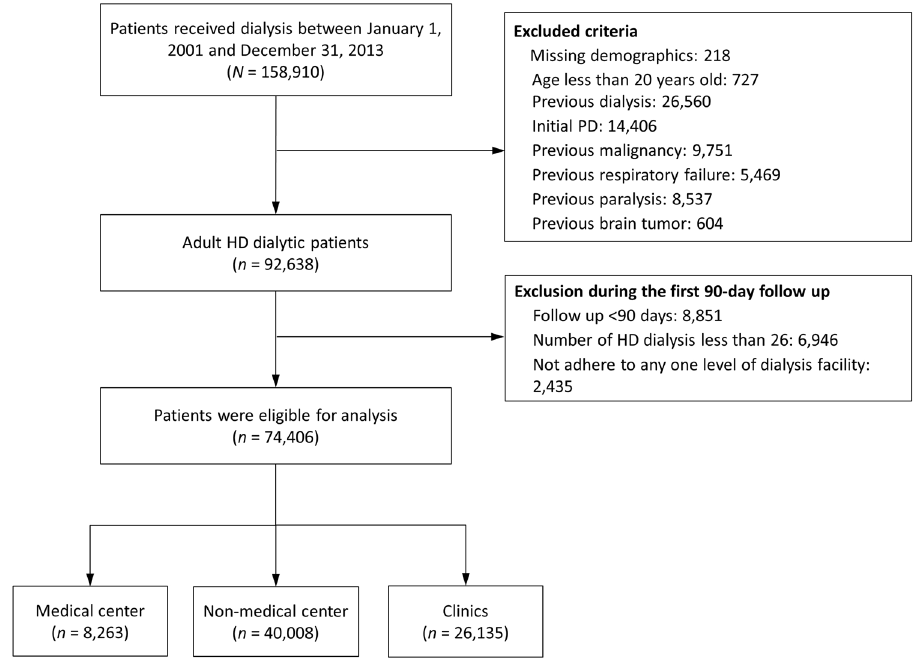
Figure 1. Flowchart for patient